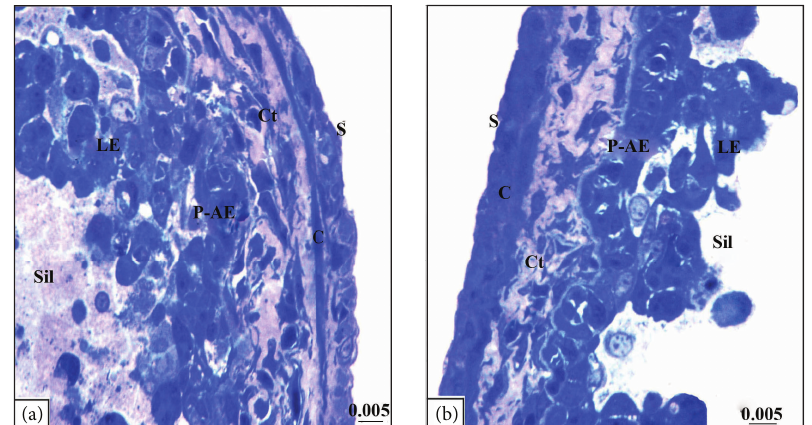
Figure 3: ((a)-(b)) Photomicrographs of transverse semithin sections of stage 63 stained with Toluidine blue showing the apoptotic larval epithelium cells and cellular debris within the small intestinal lumen. S: serosa; C: circular muscle layer; Ct: connective tissue; P-AE: adult epithelial primordia; LE: larval epithelium; Sil: small intestinal lumen. The length unit for scale bars is